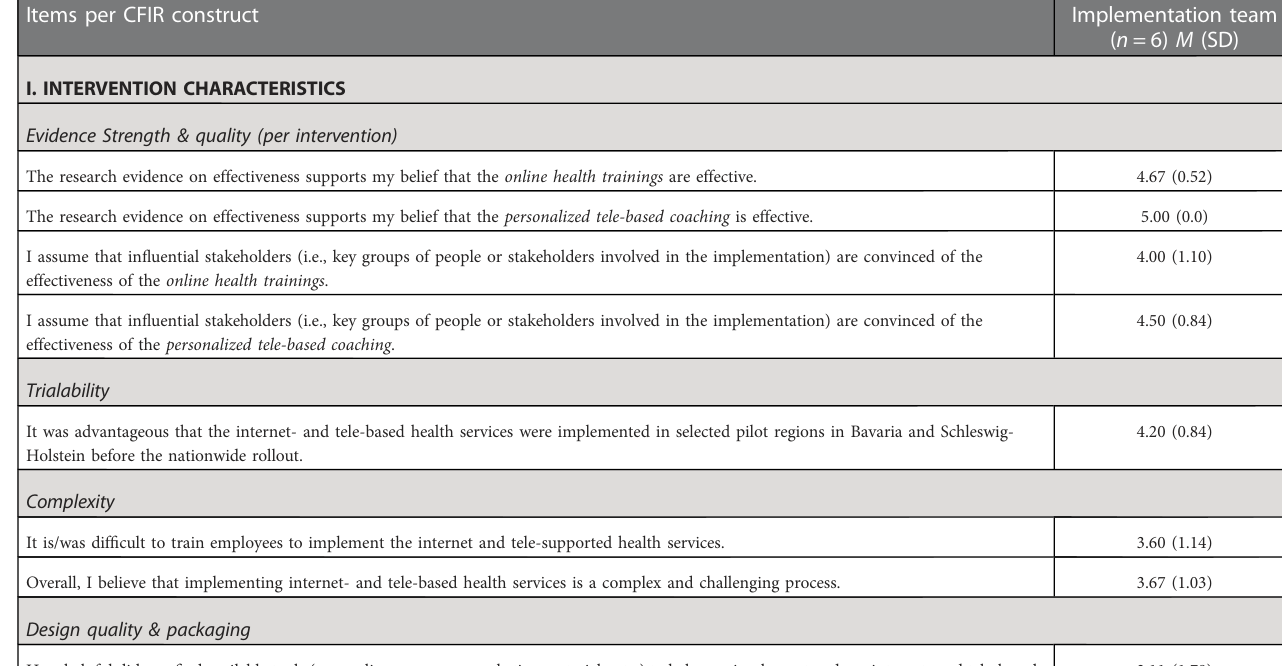
TABLE 4 Descriptive data of the implementation team on implementation determinants based on CFIR dimensions ( n =6). Items per CFIR